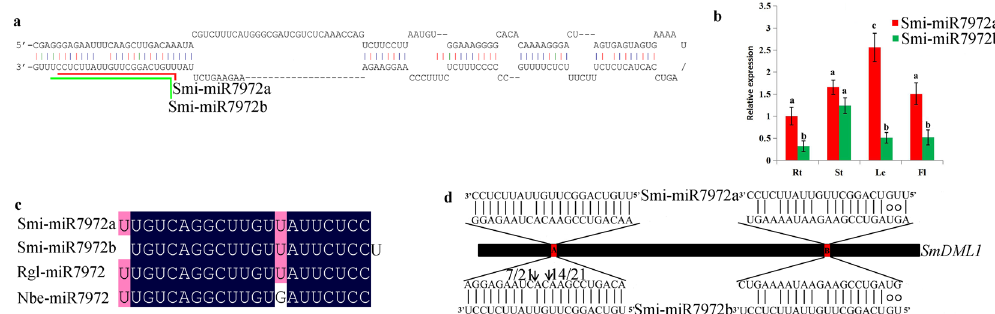
Figure 7. Smi-miR7972 in S . miltiorrhiza . ( a ) The hairpin structure of Smi-miR7972. Smi-miR7972a and Smi- miR7972b are indicated by red and green lines. ( b ) Expression patterns of Smi-miR7972a and Smi-miR7972b in roots (Rt), stems (St), leaves (Le) and flowers (Fl) of S . miltiorrhiza . Fold changes of Smi-miR7972a and Smi- miR7972b are shown. Expression level of Smi-miR7972a in roots was arbitrarily set to 1 and the levels of Smi- miR7972a and Smi-miR7972b were given relative to this. Error bars was indicated by the standard deviations of three biological replicates. ( c ) Sequence alignment of miR7972s from S . miltiorrhiza , R . glutinosa and N . benthamiana . ( d ) Validation of Smi-miR7972a- and Smi-miR7972b-mediated cleavage using the modified 5 ′ RLM RACE method. Heavy black line represents open reading frame of SmDML1 . The complementary sites of Smi-miR7972 in SmDML1 are represented by A and B and shown in red. The nucleotide sequences of Smi- miR7972a and Smi-miR7972b from 3 ′ to 5 ′ and the complementary sites of SmDML1 from 5 ′ to 3 ′ are shown in the expanded regions. Vertical dashes indicate Watson-Crick pairing. Circles indicate G:U wobble pairing. Vertical arrows indicate the 5 ′ termini of Smi-miR7972-mediated cleavage products, as obtained by 5 ′ RLM- RACE, with the frequency of clones